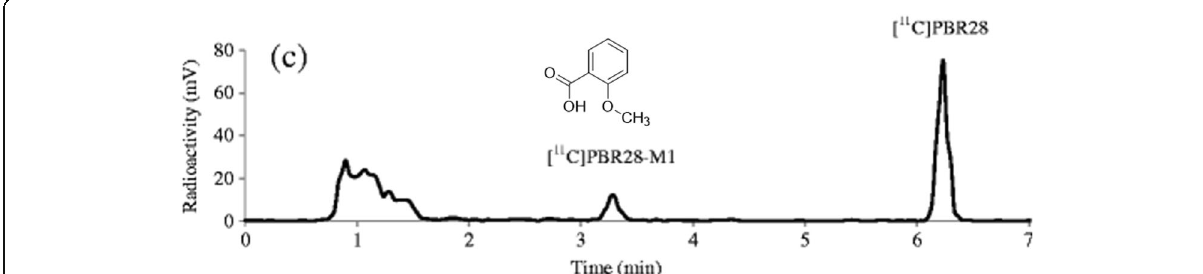
Fig. 5 Fast radio-LC chromatograms of human plasma collected 10 min after administration of [ 11 C] PBR28. The radioligands and their identified radiometabolites are marked on each chromatogram. Adapted with permission from Ref.